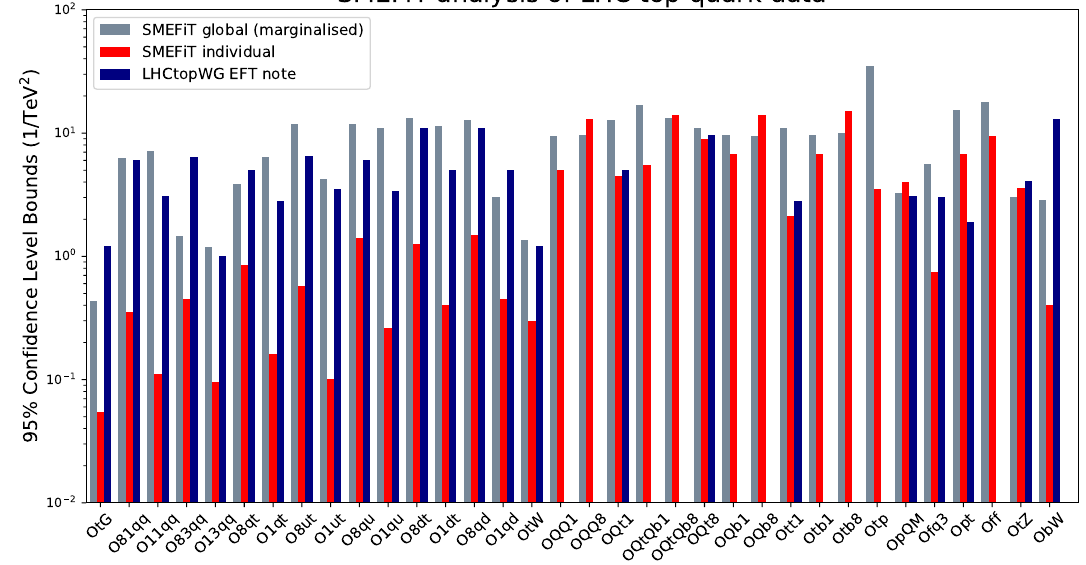
Figure 19 . Graphical representation of the results of tables 8 and 10, where we compare the